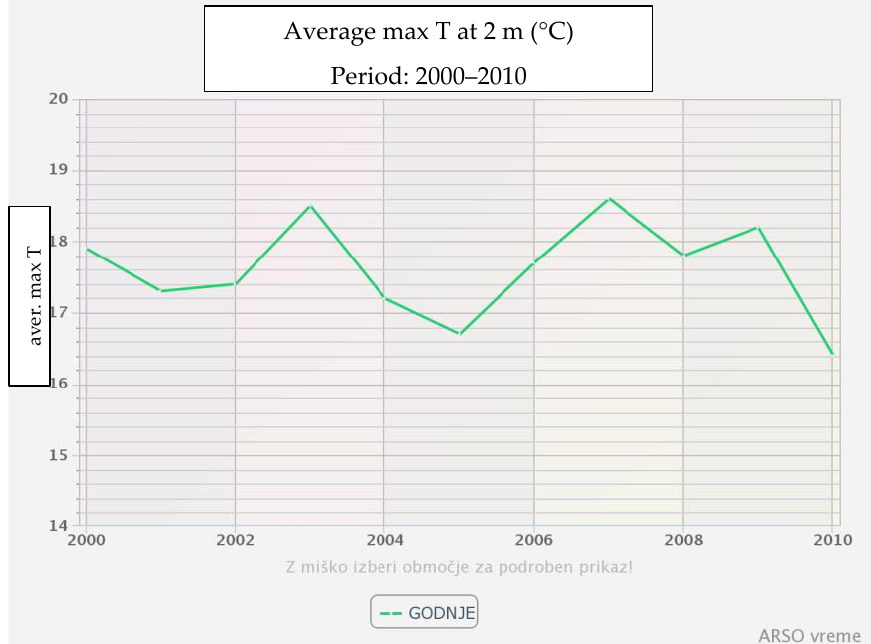
Horticulturae 2023 , 9 , 206 Figure 3. Average maximum temperature for locality 6 — Slivje, measured from nearby climate sta- Figure 3. Average maximum temperature for locality 6—Slivje, measured from nearby climate station